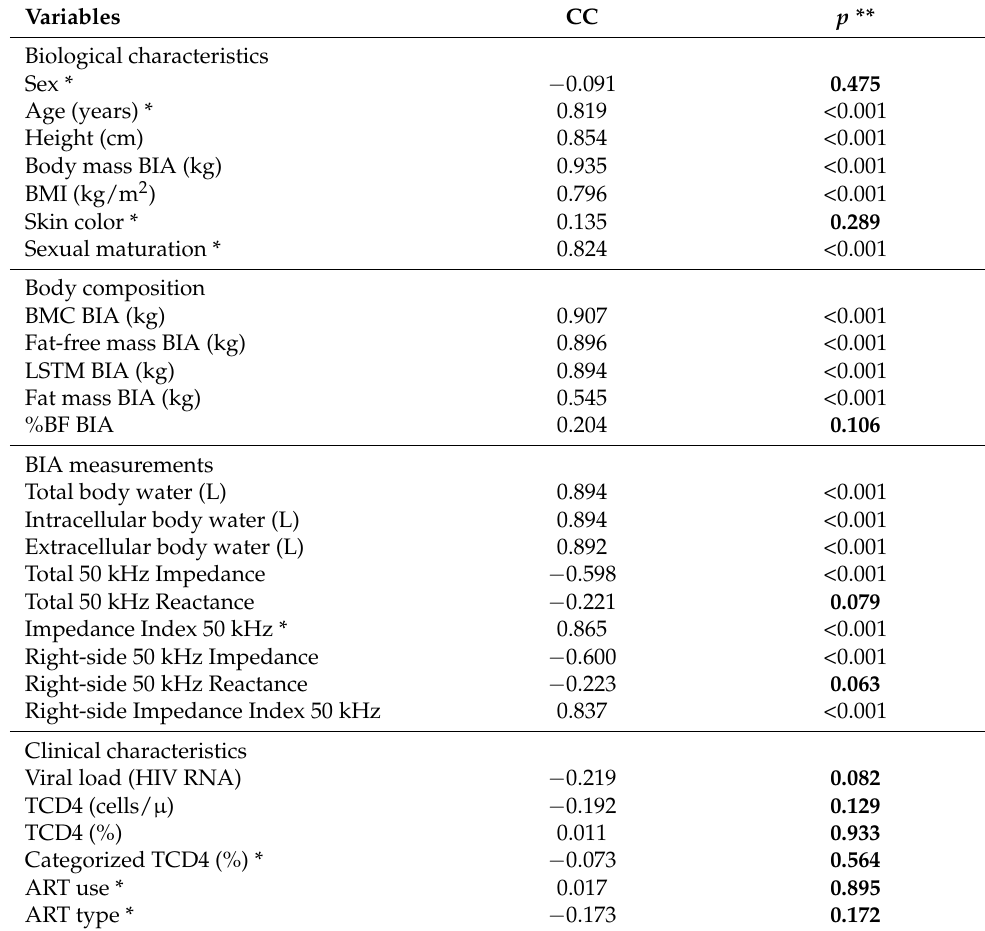
Table 2. Subjects characteristics and dual energy X-ray absorptiometry (DXA) bone mass content (BMC)